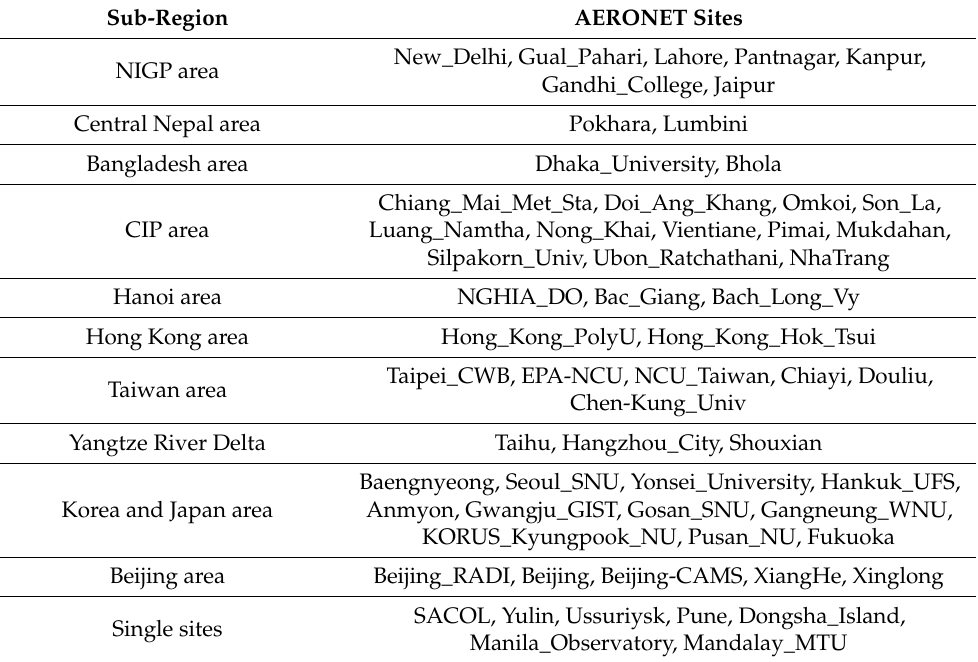
Table 4. The AERONET sites within the divided